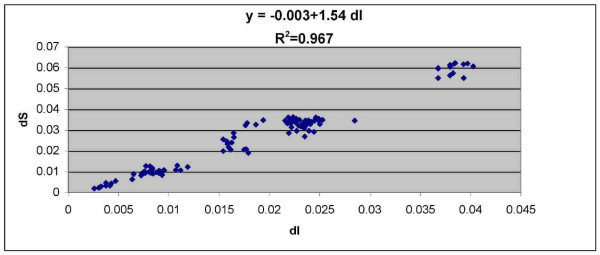
the rate of substitution at synonymous sites (dS) plotted against the rate of substitution at noncoding sites (dI) for all paiwise comparisons within the Bovini tribe.